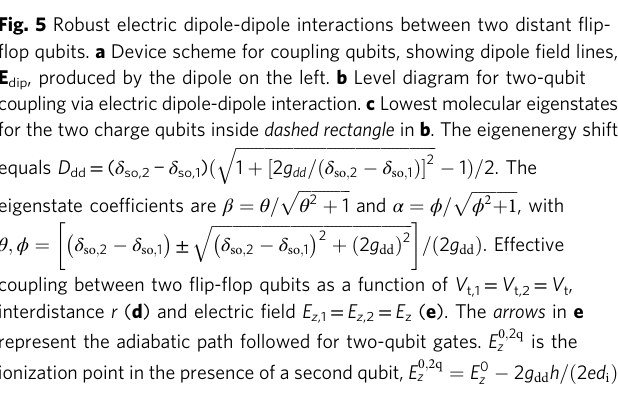
ffiffiffiffiffiffiffiffiffiffiffiffiffiffi p i SWAP gate, for K = 30, r = 180 nm, B 0